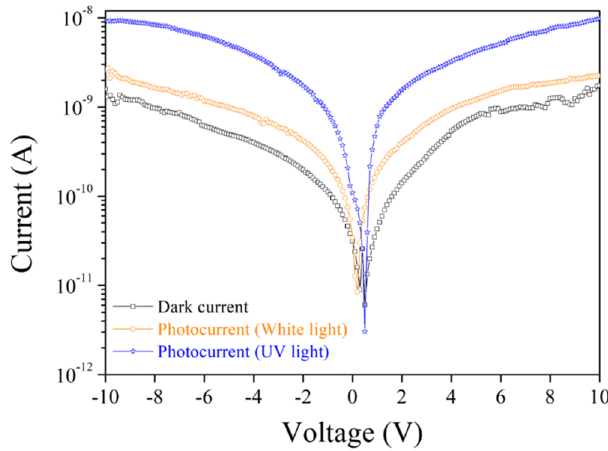
Figure 5d, the photocurrent under the I–V measurement, compared to the dark current, was observed to increase obviously under UV light irradiation compared to white light illumination. The photocurrent of 2D perovskite increased by one order of magnitude compared to the dark current under UV light irradiation.